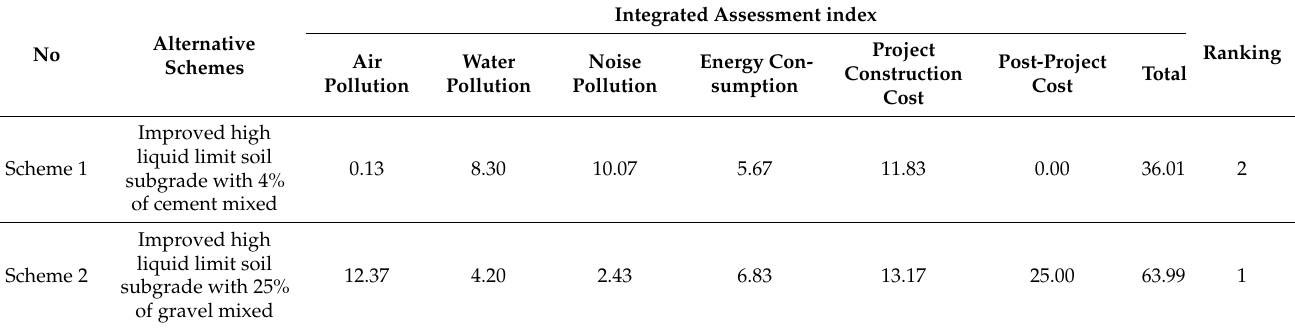
Table 7. Integrated assessment index